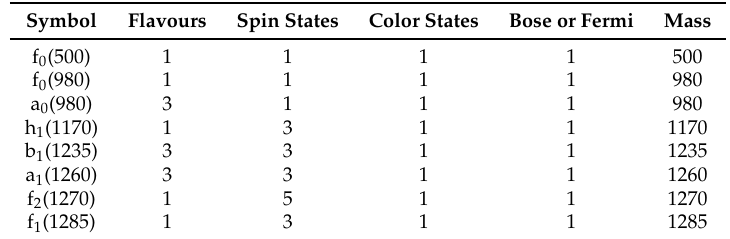
Table C3. Excited unflavoured